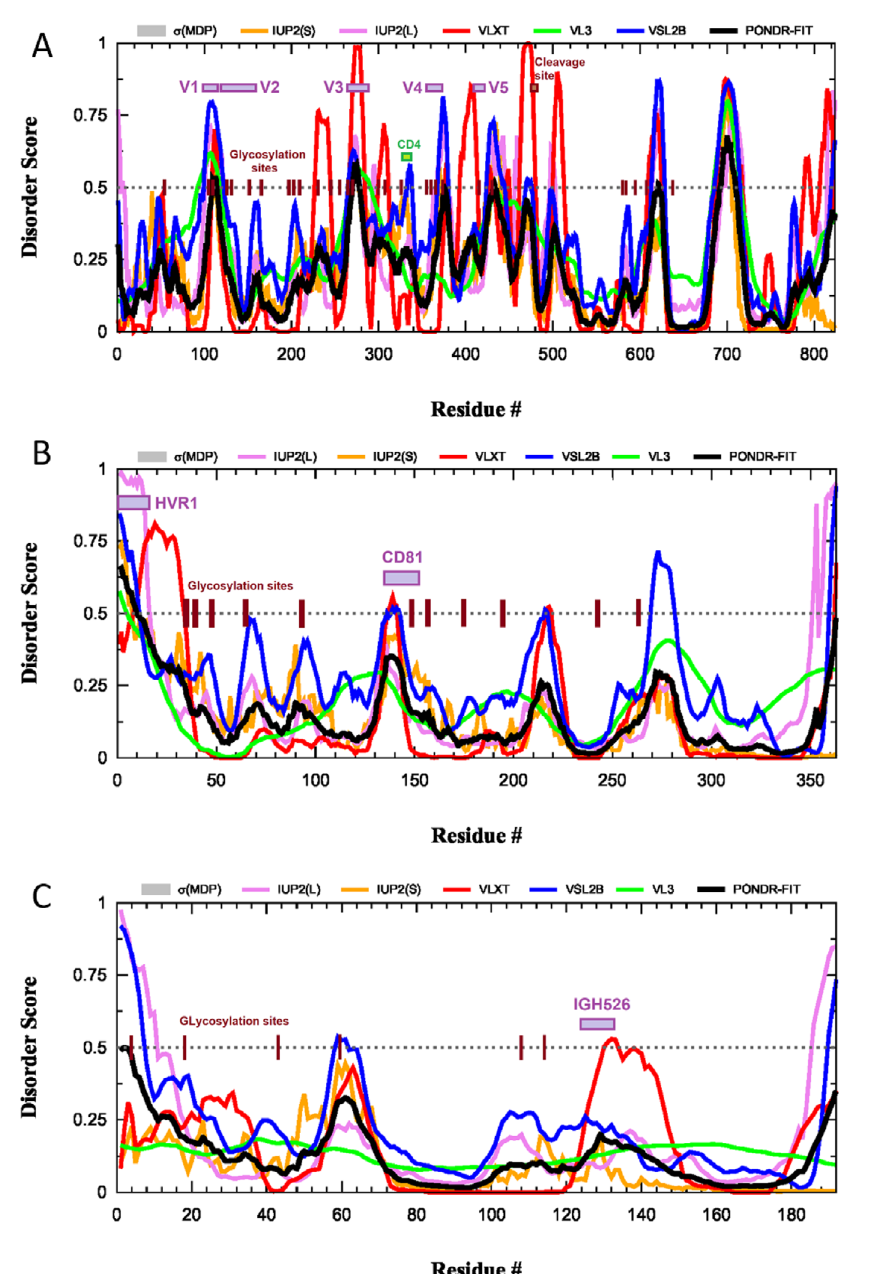
Figure 2. Intrinsic disorder predisposition of HIV-1 surface glycoprotein gp160 (A) and the HCV glycoproteins E2 (B) and E1 (C). Disorder profiles are generated using the RIDAO platform designed to aggregate the results from a number of well-known disorder predictors, such as PONDR ® VL3 [59], PONDR ® VLXT [60], PONDR ® FIT [61], PONDR ® VLS2 [62], IUPred2 (Short), and IUPred2 (Long) [63–65]. Dotted lines show the disordered threshold of 0.5 that separates ordered residues [predicted disorder scores (PDS) < 0.5] and intrinsically disordered residues (PDS ≥ 0.5). Based on their PDS values, ordered residues are further subdivided to highly ordered [PDS (0.15) and flexible (0.15 ≤ PDS < 0.5)]. Locations of functional regions and sites of N-glycosylation in all three proteins are shown by colored boxes and dark brown ticks. σMDP: mean disorder prediction; CD4: